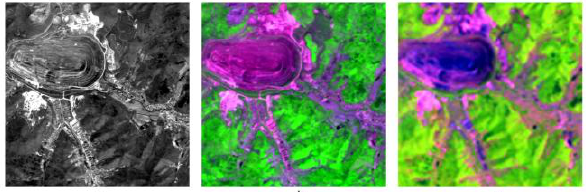
Figure 2. The ALOS and TM original image of the first dataset. (a) is original image of ALOS panchromatic band, (b) is the synthetic image of ALOS 342 multispectral bands, and (c) is the synthetic image of TM 543 multispectral bands.